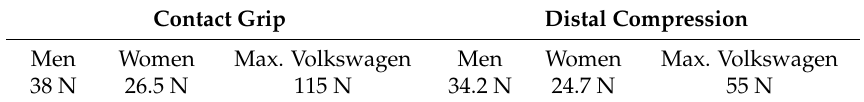
Table 2. Maximum force values during the internal and external test for men and women.